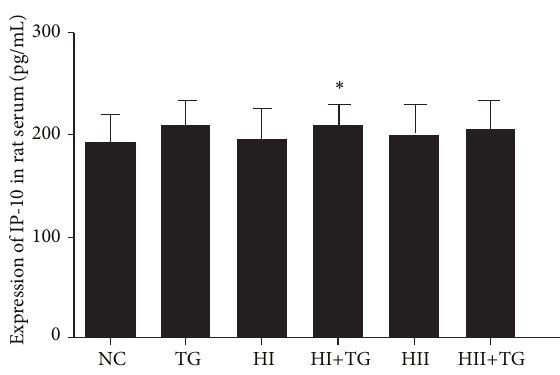
Figure 4: Bars in this figure show differential expression of IP-10 in the serum of rats in each group. Expression of serum IP-10 was measured usingELISA.SerumIP-10levels intheHI+TGgroupwere significantly higher than those in the NC group.